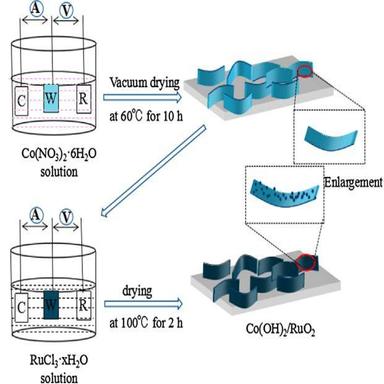
Schematic illustration of the synthesis of the Co(OH)2/RuO2 nanocomposite on the nickle foam.